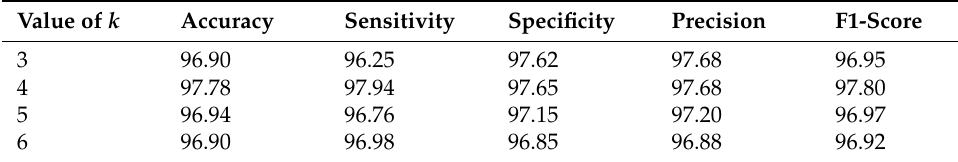
Table 6. Results of the CGENet with different graph embeddings (unit: %). Value of